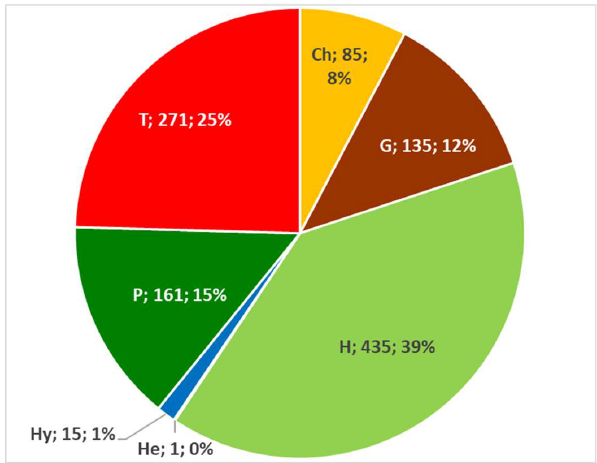
Figure 13. Composition in absolute and percentage value of the Italian edible spontaneous taxa biological spectrum. Ch = Chamaephytes; G = Geophytes; H = Emicryptophytes; He = Helophytes; Hy = Hydrophytes; P = Phanerophytes; and T = Therophytes. The widespread presence of Hemicryptophytes is mainly due to their habitus, because they be either biannual ( Crepis vesicaria , Daucus carota ) or perennial species ( Cichorium intybus , Plantago lanceolata , Foeniculum vulgare ). Among the various sub-forms, the most relevant in percentage terms include scapose plants (H scap), accounting for 22.48%, of which mainly the basal rosettes and leaves are used (e.g., Cichorium intybus